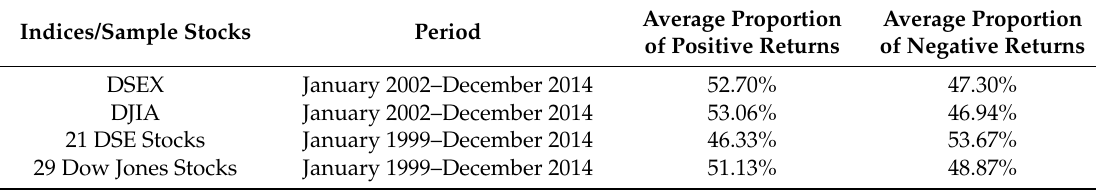
Table 1. Proportion of Positive and Negative Returns (DSE vs.